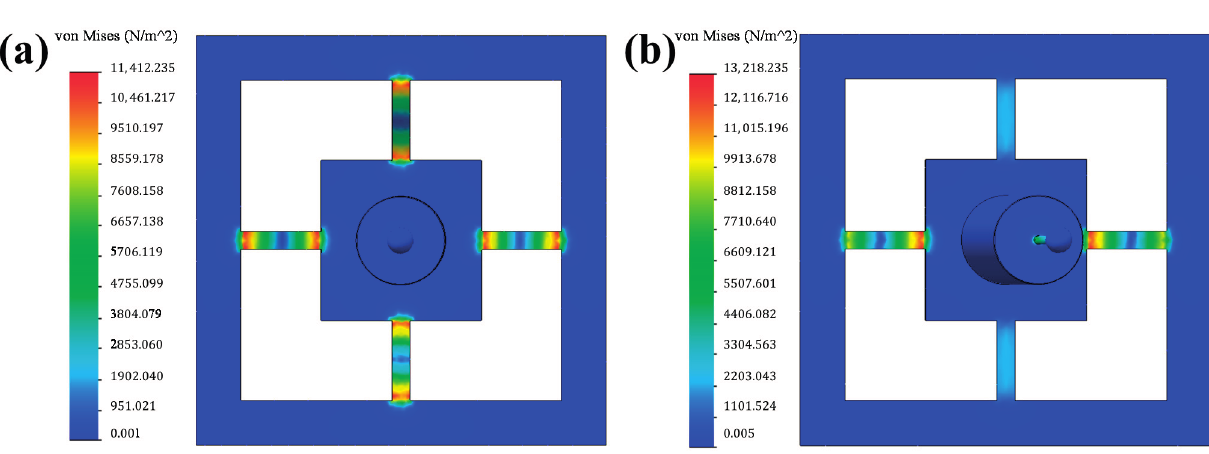
Figure 3. Stress distribution. ( a ) Axial load; ( b ) Lateral load.